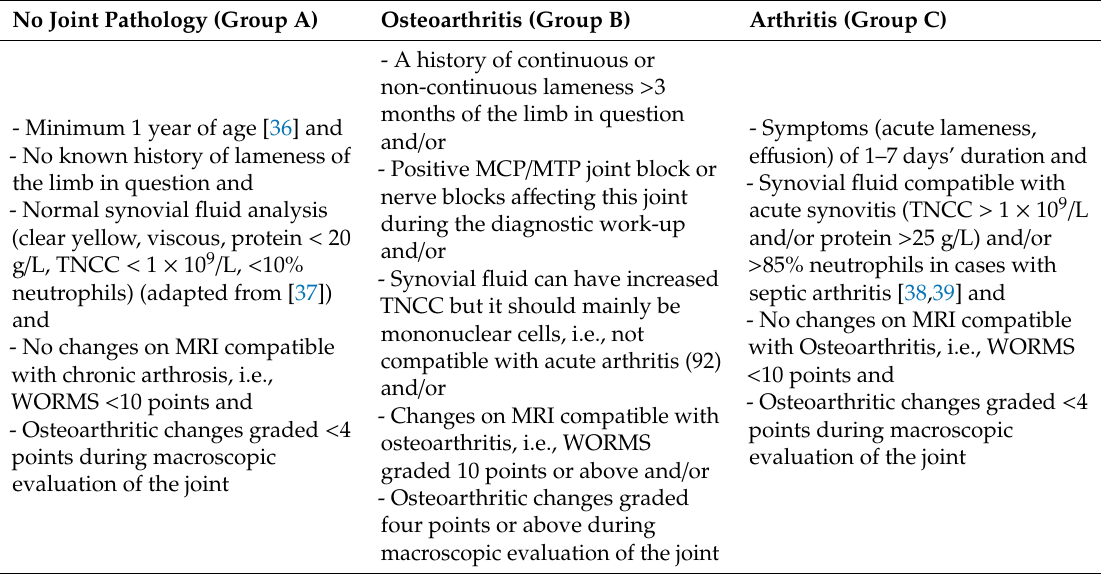
Table1. Categorizationofjointdiseaseanddivisionofhorsesintothreegroups(totalnucleatedcellcount (TNCC); magnetic resonance imaging (MRI); whole organ MRI score (WORMS); Ymetacarpophalangeal (MCP); metatarsophalangeal